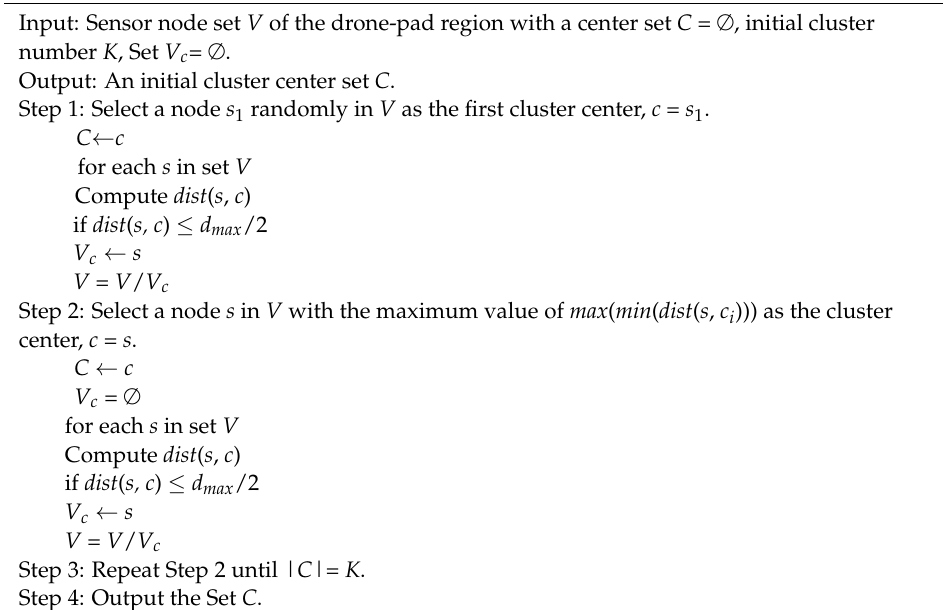
Algorithm 1 Selecting the initial cluster centers